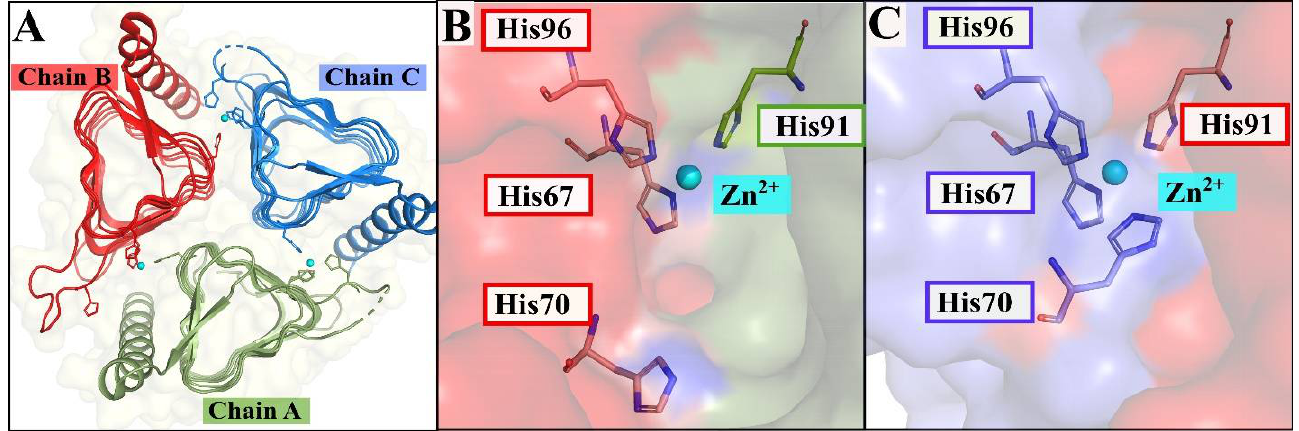
Figure 1. Crystallized structure of the γ-CA from Escherichia coli (EcoCA-γ, PDB ID: 3TIS). ( A ) Structure of EcoCA-γ with the proton shuttling residue, His70, as well as Zn 2+ -coordinating His residues shown as sticks. Zn 2+ is represented as cyan-colored spheres. ( B ) Active site between chains A (green) and B (red) showing the protein surface and the orientation of His70, which results in an “open” or unblocked active site. ( C ) Active site between chains B (red) and C (blue) showing the protein surface and the orientation of His70, which results in a “closed” or blocked active site.